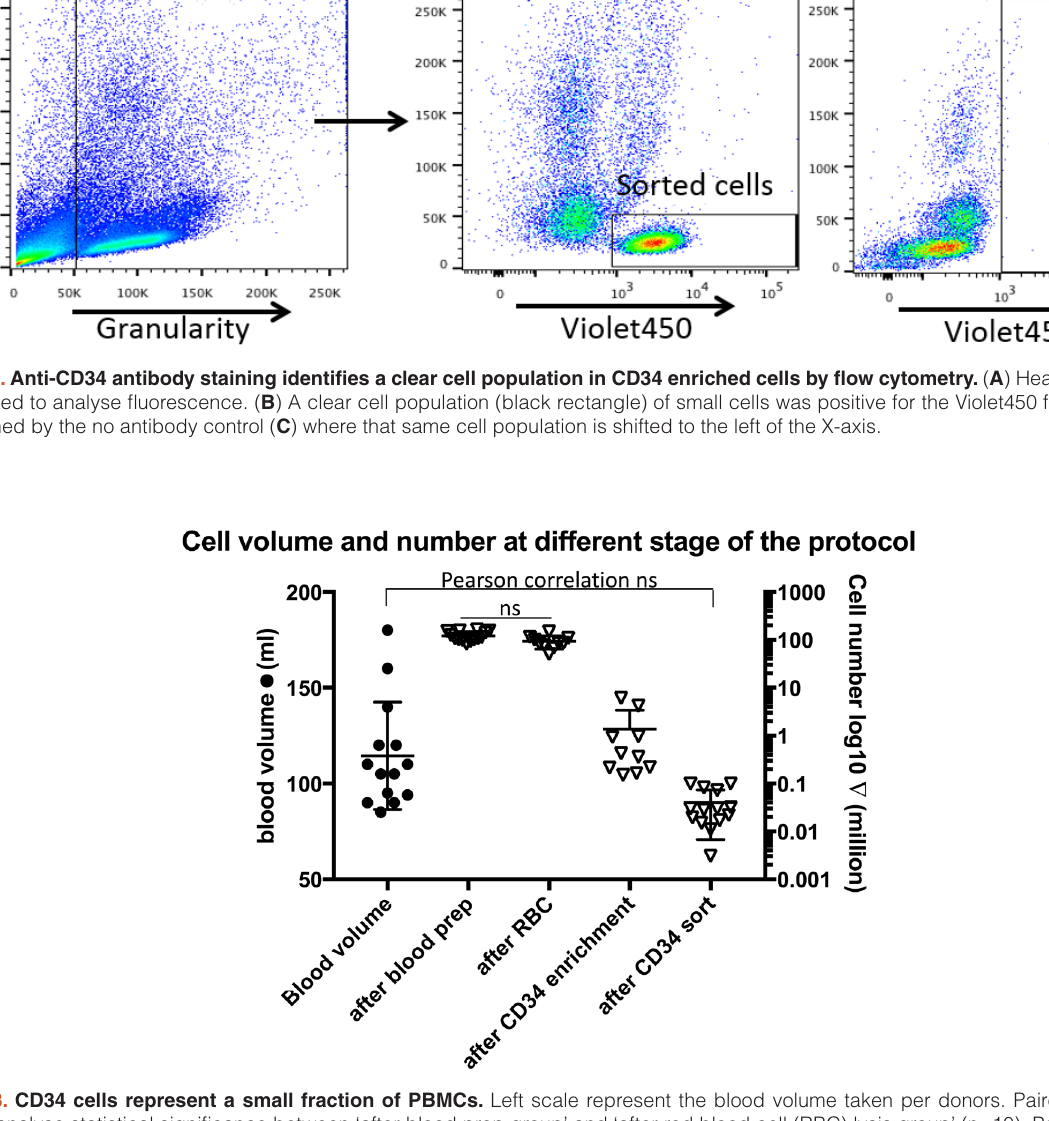
CD34 cells and no correlation was found (p= 0.115, n=14, Pearson r=0.441). This may be due to the high variability in the pool of CD34 cells between